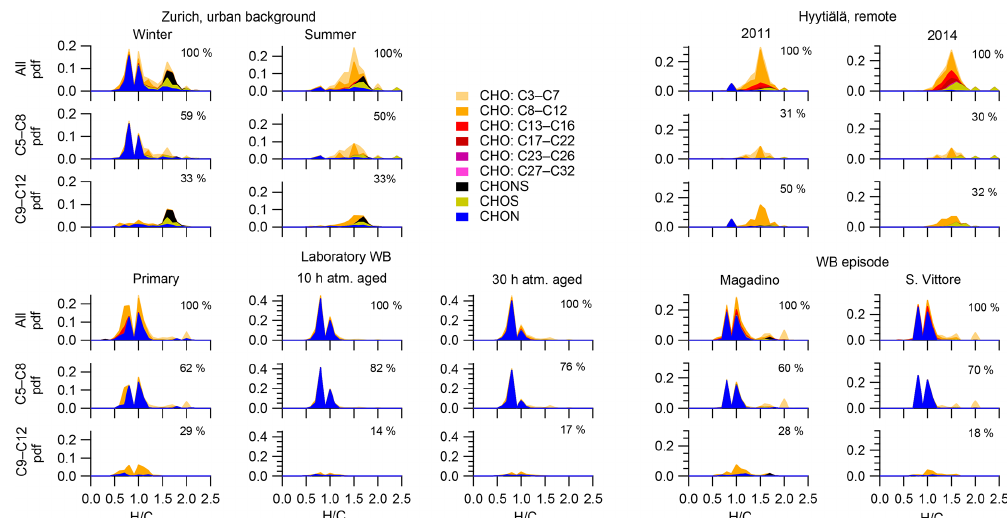
Figure 5. Probability density functions (pdf) and contributions of different molecule families to H / C for all molecules (neutral composition based on (-)ESI-ultra-high-resolution mass spectra), molecules with 5 to 8 carbon atoms, and 9 to 12 carbon atoms for the ambient samples collected in Zurich, Magadino, San Vittore, and wood-burning smog chamber experiments. The area of the histograms is proportional to the percentage of the total signal explained for each